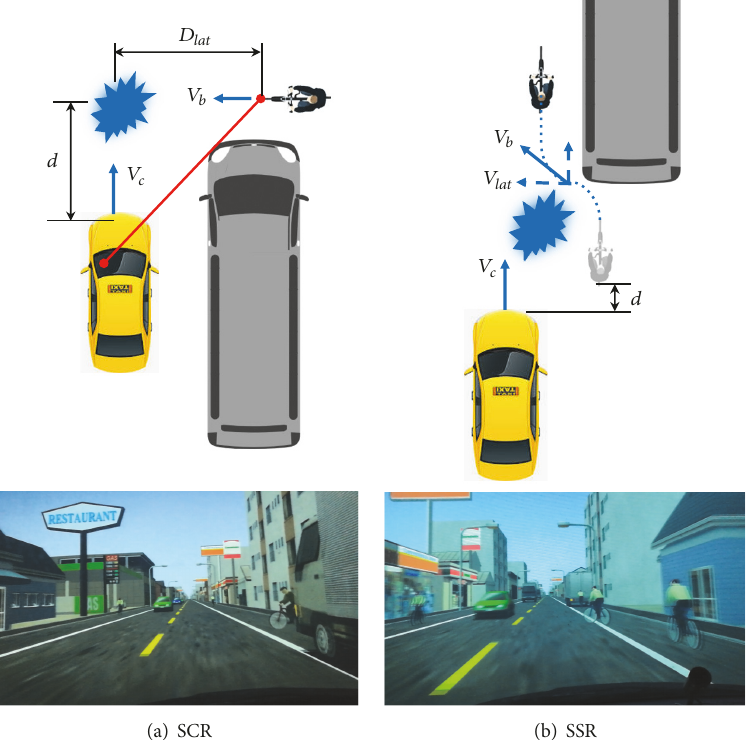
Figure 2: Reconstruction of typical V-B conflicts and different motion pattern parameters (SCR: bicycle crossing, SSR: bicycle swerving). ∘ six-degree-of-freedom moving base, which provided a ± 15 angular and ± 0.4m longitudinal moving range. The driving simulator realized the same functions as a real car, including accelerating, steering, and braking, which provided driving experience to participants as realistic as possible. Spatial posi- tions of all the vehicles and bicyclists in the simulation as well as participants’ driving performance data (e.g., speed, acceler- ation, and steering wheel angle) were recorded at 60